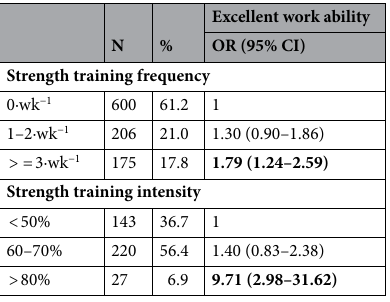
Table 2. ORs for having excellent work ability (analyses controlled for gender, education, experience, and working hours per week) (reference: no excellent workability). Bold letters denote statistically significant